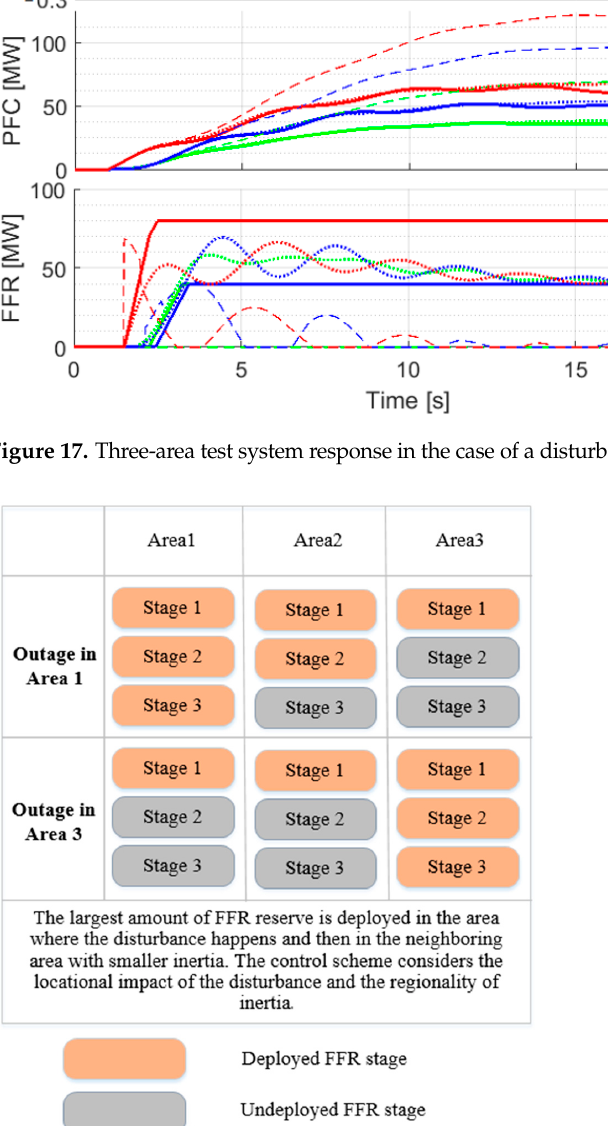
Figure 19. Provision costs of FFR service. 4.2. Simulations on an IEEE 68-Bus System The IEEE 68-bus system consists of five well-connected areas (A1-A5), and it is a standard test system for dynamic stability analysis [36,37]. Area 1 represents the New England system, area 2 is the system of New York and areas 3, 4 and 5 are represented by an equivalent generator. The state described in [37] was selected as the initial operating